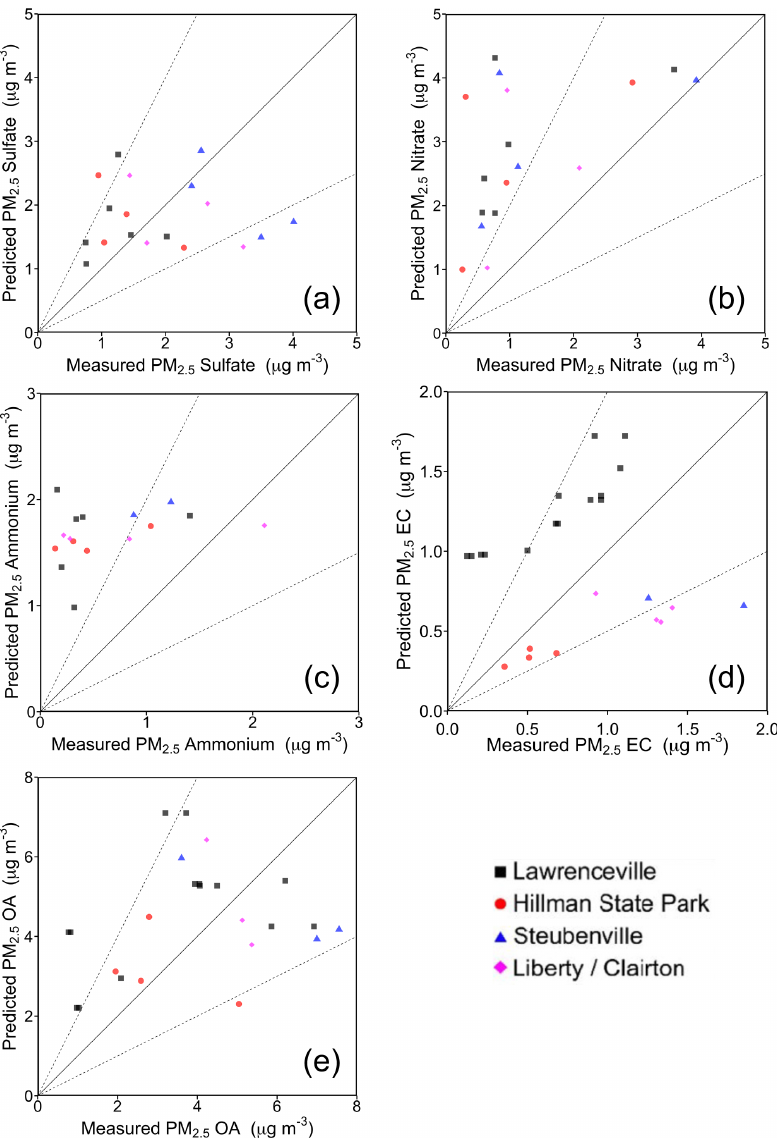
Figure 2. Comparison of daily average PMCAMx-v2.0-predicted concentrations of PM 2 . 5 (a) sulfate, (b) nitrate, (c) ammonium, (d) ele- mental carbon, and (e) organic aerosol with daily measurements from EPA-CSN sites during February 2017.